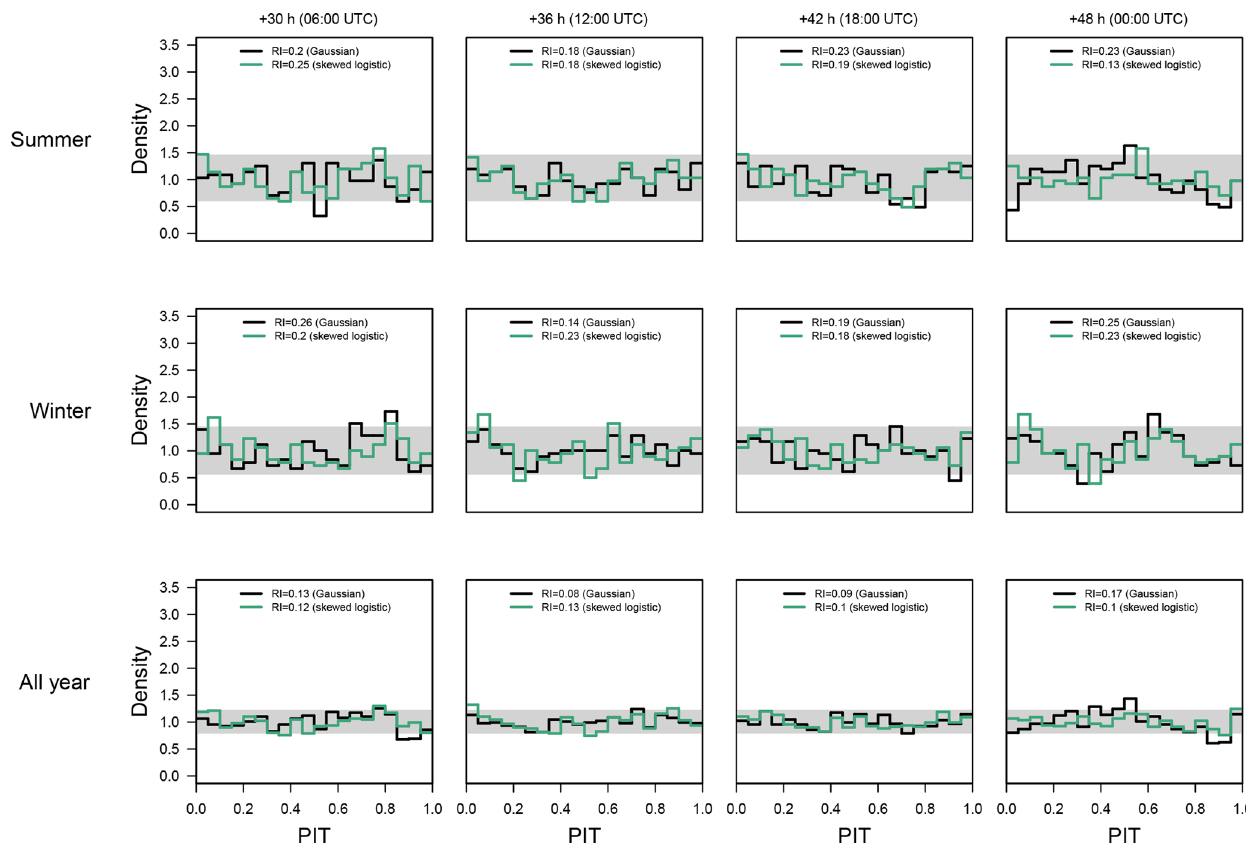
Figure 4. PIT histograms at the Alpine site for the Gaussian (black/dark line) and skewed logistic (green/bright line) models for the 2d ahead forecasts (left to right: 06:00, 12:00, 18:00, and 00:00UTC) corresponding to forecasts + 30, + 36, + 42, and + 48h ahead. Top down, the PIT histograms are shown for summer only (June/July/August), winter only (December/January/February), and for the whole year. The gray horizontal bar shows the point-wise 95% confidence interval around 1 which indicates perfect